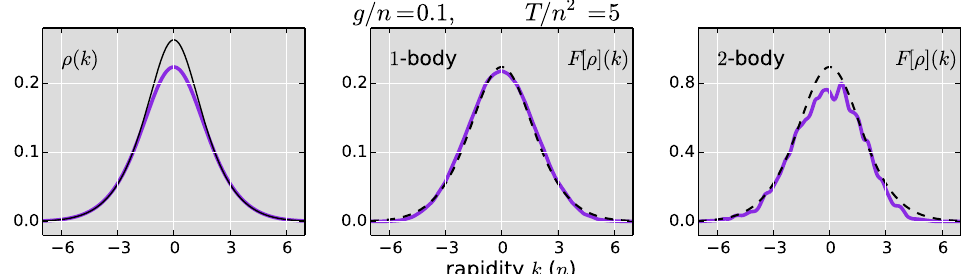
Figure 2: Left: distribution of rapidities ρ ( k ) in the thermal state for T = 5 n 2 and g = 0.1 n , compared with the Bose-Eistein distribution (thin black line). Center and Right: the corresponding F [ ρ ] , calculated numerically using Eq. (7), for K = 1,2 respectively. The black dashed line corresponds to KK ! ρ ( k ) . The results for K = 1 (resp. K = 2) are obtained by summing over 10 4 (resp. 2.10 3 ) independent pairs of Bethe states for N (cid:39) 30 atoms. We use a Gaussian of width σ = 0.15 n to smoothen the rapidity